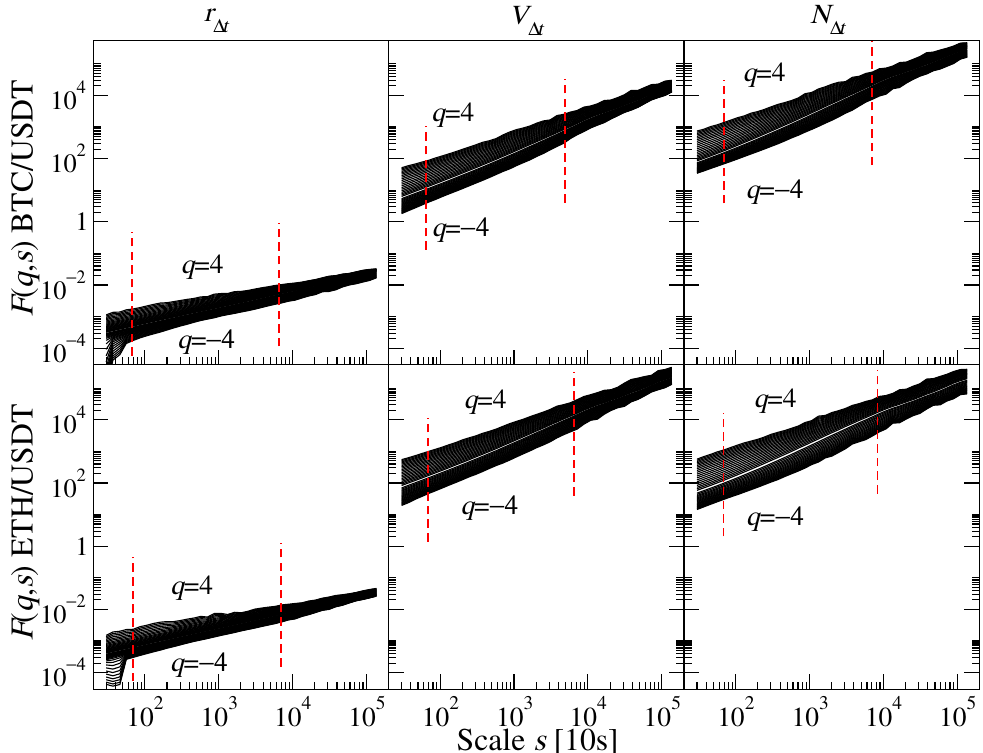
Figure 3. Univariate fluctuation functions F XX q ( s ) calculated for time series of price returns r ∆ t ( t ) ( left column ), volume traded V ∆ t ( t ) ( middle column ), and the number of transactions N ∆ t ( t ) ( right column ) for two cryptocurrencies expressed in USDT: BTC ( top ) and ETH ( bottom ). In each panel, vertical dashed lines denote a range of time scales s for which a power-law model can be fitted to the fluctuation functions. A range of values of q is also